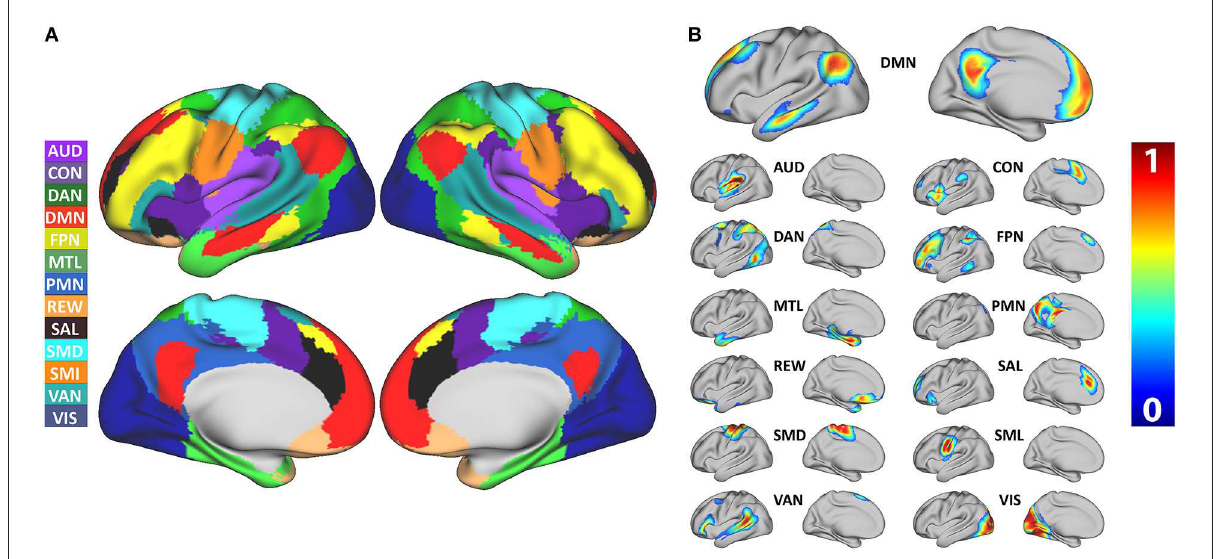
FIGURE2 (A) Surface segmentation of resting state networks based on maximum probability produced by the 3DCNN averaged across 2,010 participants. (B) Probability maps of individual resting state networks averaged across 2,010 participants. SMD, dorsal somatomotor; SML, lateral somatomotor; CON, cinguloopercular; AUD, auditory; DMN, default mode; PMN, parietal memory; VIS, visual; FPN, frontoparietal; SAL, salience; VAN, ventral attention; DAN, dorsal attention; MTL, medial temporal; and REW, reward.